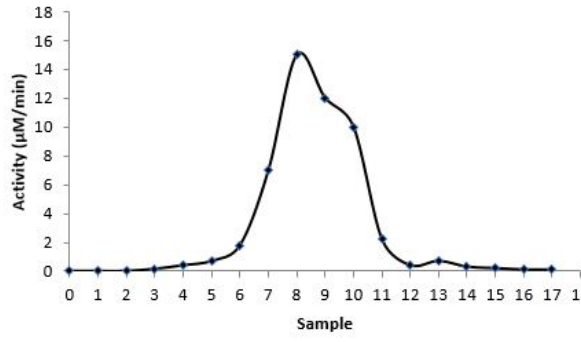
Figure 1: Purification profile of C. lanatus rind invertase by sephadex G-25 gel filtration.